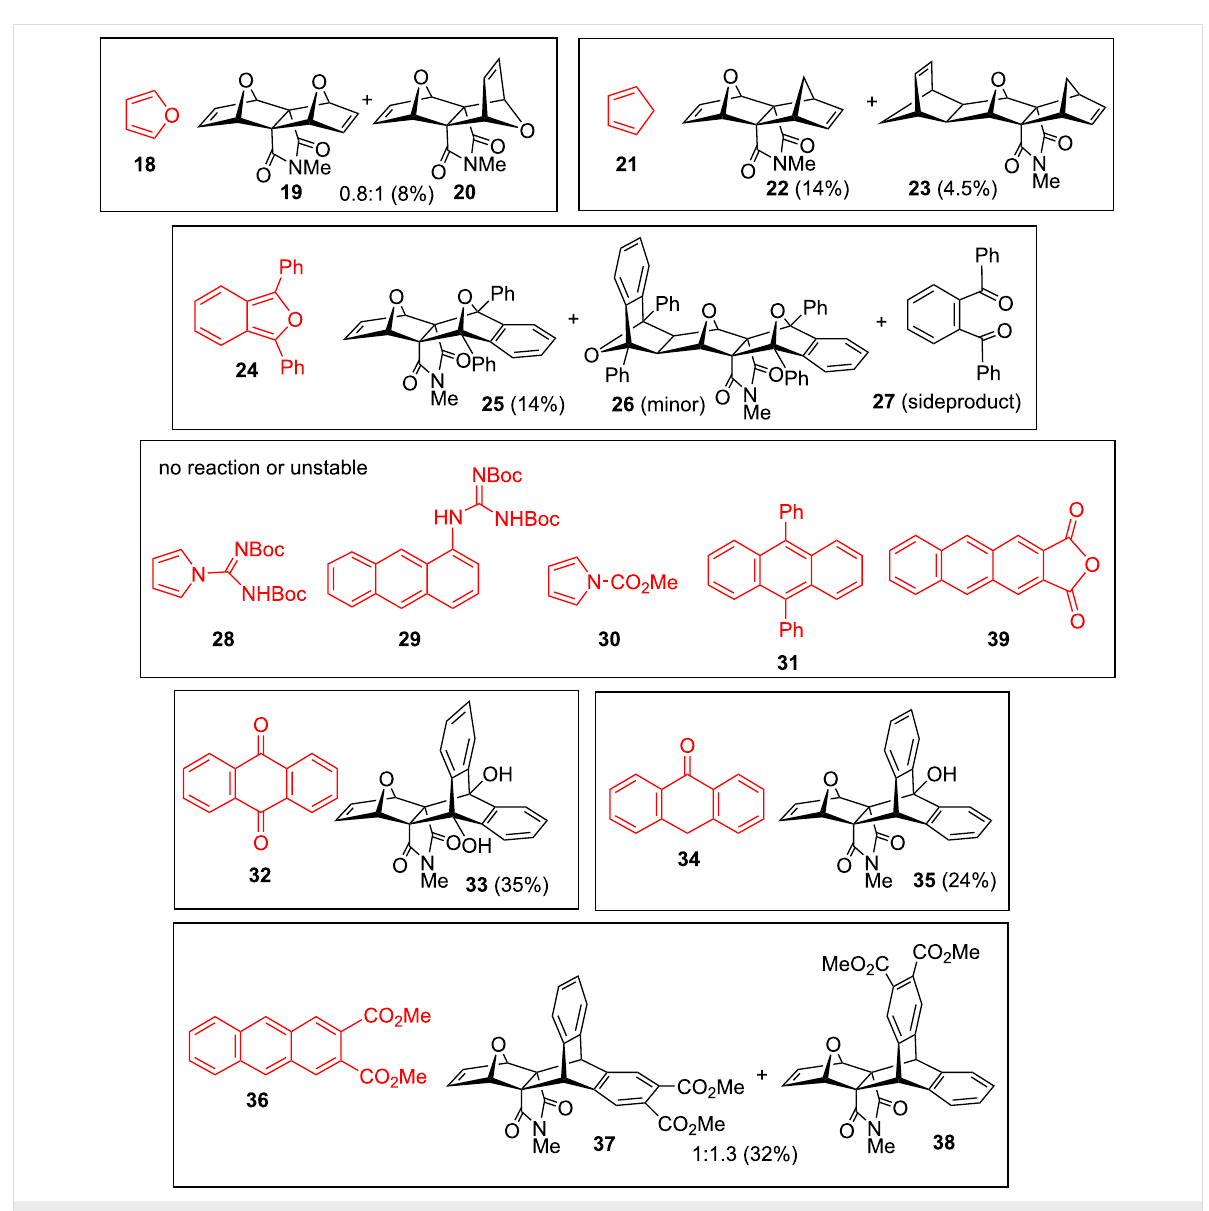
Figure 3: Scope of the Zn/Cu reaction with dibromide 10 (dienes are colored in red).